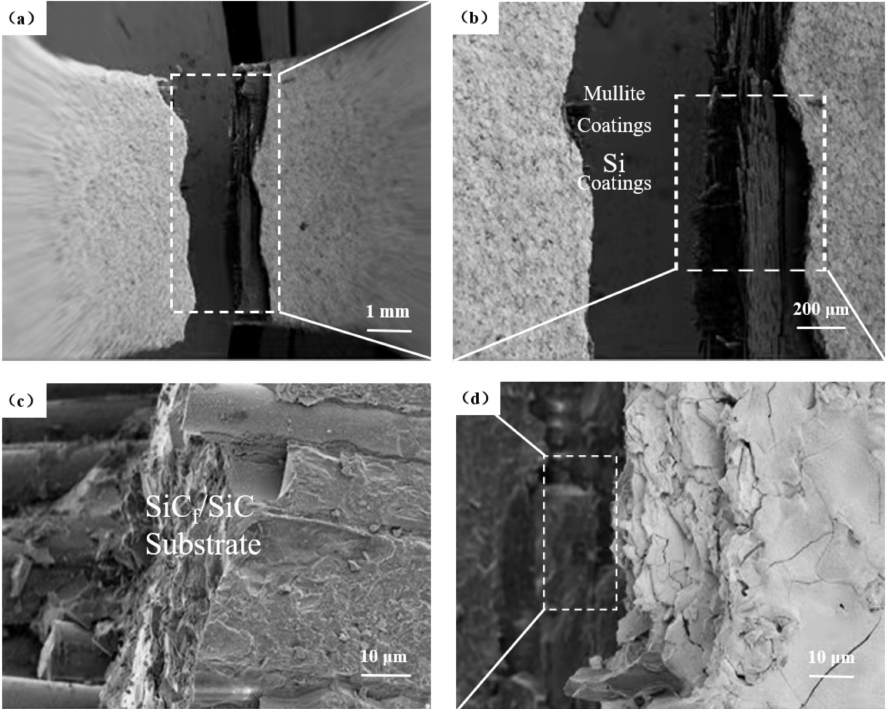
Figure 9. In situ SEM reveals microscopic features of the fracture developed under a load of 340 N in a sample held at 766 ◦ C: ( a ) fracture micromorphology; ( b ) local magnification of fracture micromor- phology; ( c ) local magnification of fractured matrix; and ( d ) local magnification of coating portion of fracture.